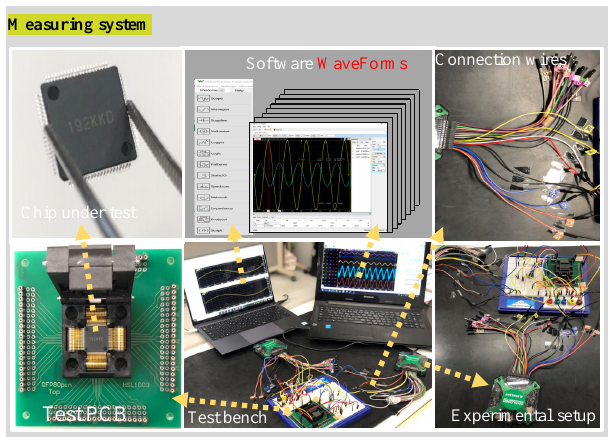
Figure 3. The general architecture of the measuring system for the perceptron